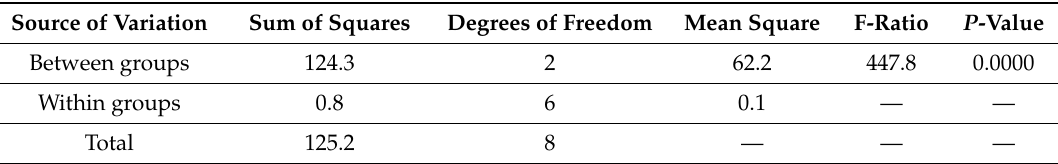
Table A2. Analysis of variance (ANOVA) corresponding to the cabuya soluble matter yield as a function of extraction stirring